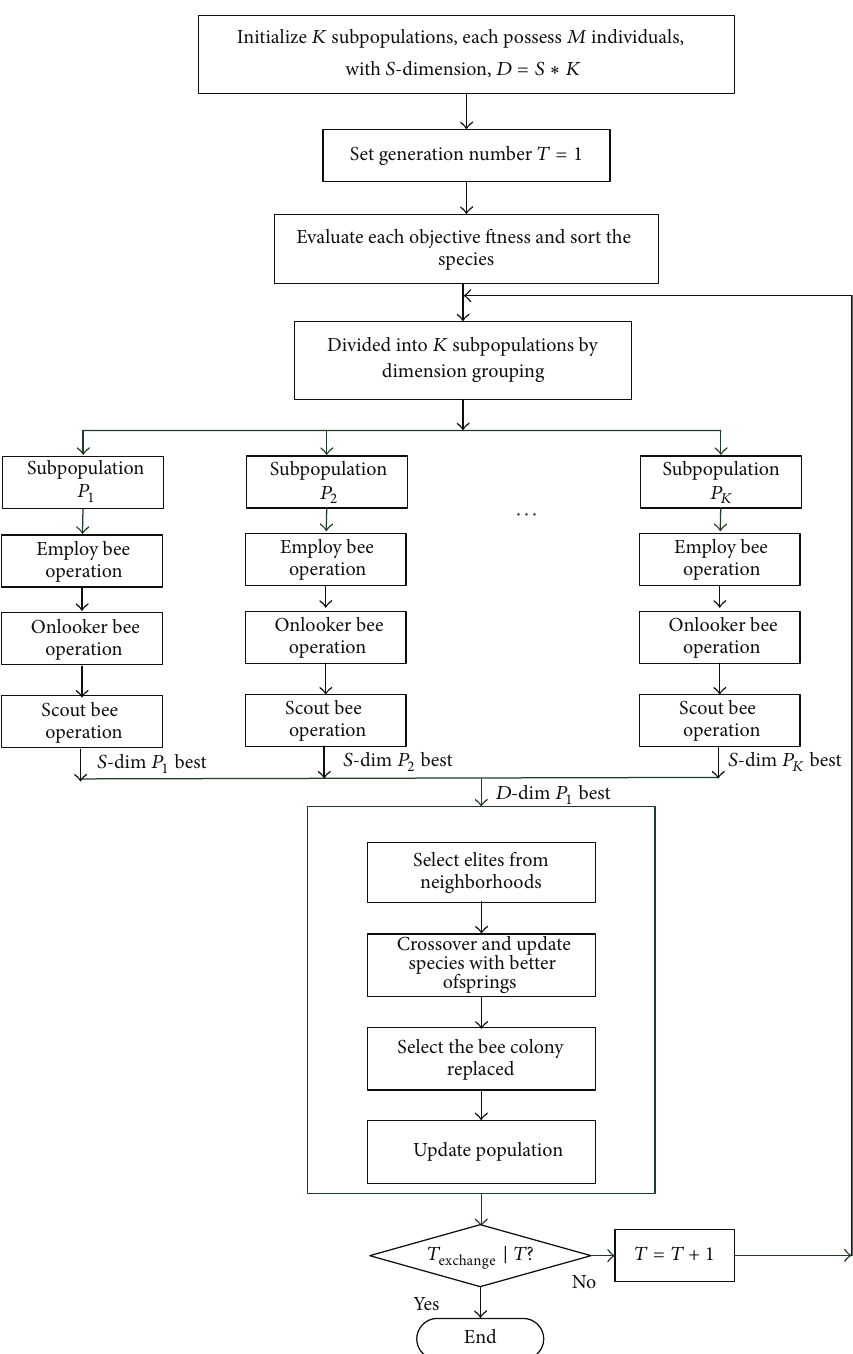
Figure 3: Flowchart of the HABC